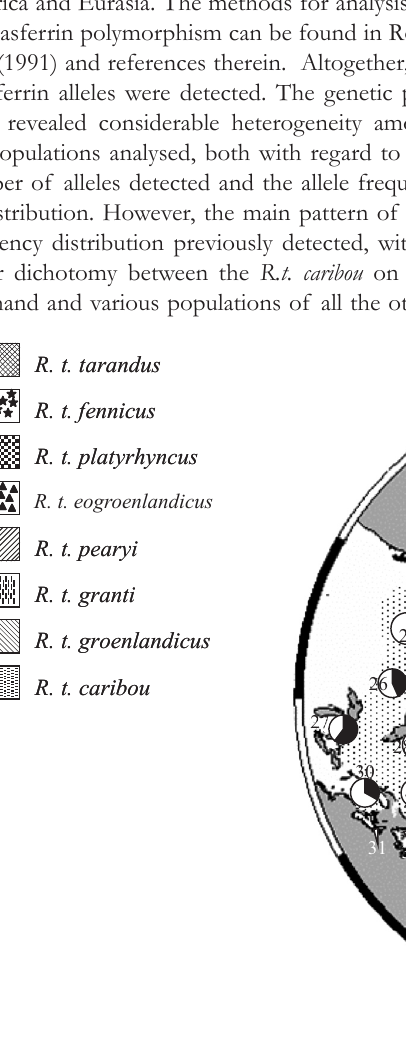
Fig. 2. Frequency distribution of three pooled transferrin alleles (Tf A-3 , Tf A-2 and Tf A-1 ) given as section of pies. Num- bers refer to the sampled population provided in Table 1. The indicated subspecies distribution is as for Fig.